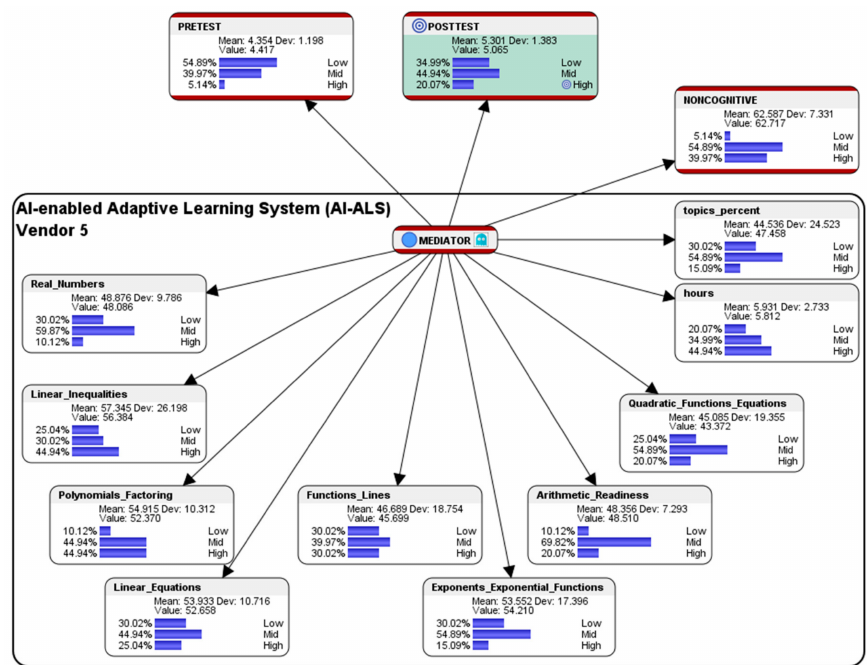
Figure 11. BN model of the students who had used the AI-ALS from Vendor 5 (N = 20